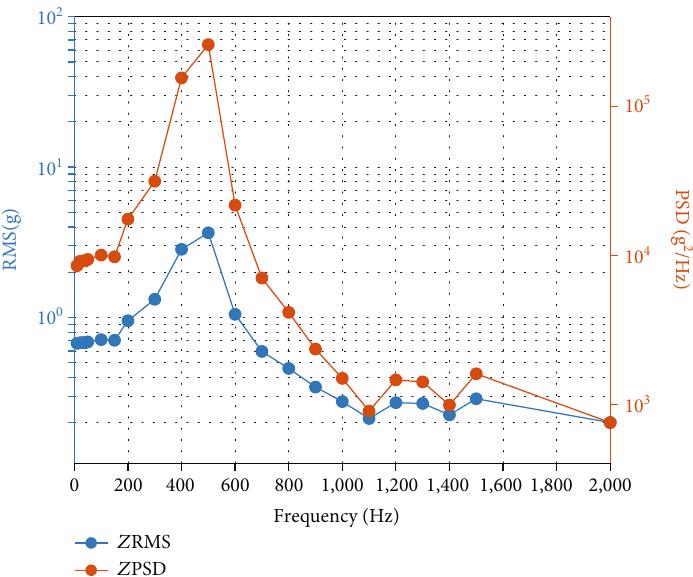
Figure 15: RMS and PSD amplitude for sinusoidal test. Lateral acceleration at the top of Simple-2 satellite.